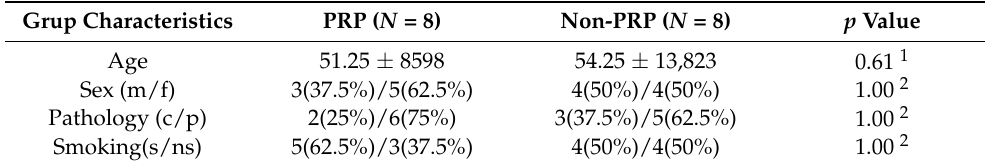
Table 1. Group Characteristics.